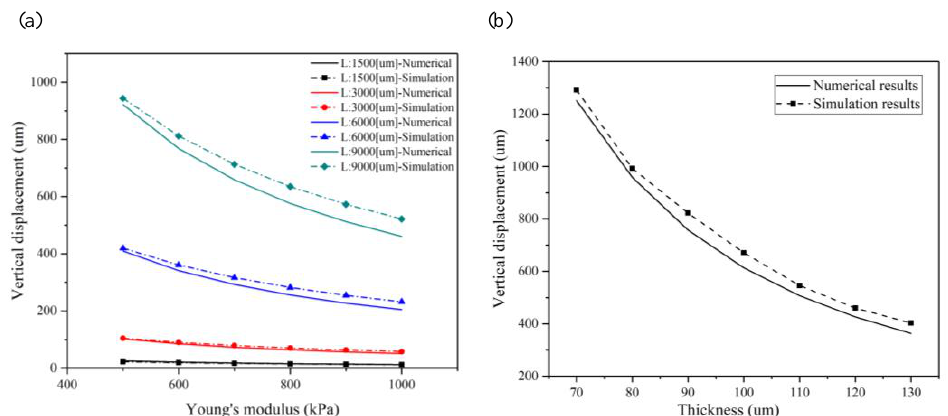
Figure 5. The numerical and simulation results of the maximum displacements at the free end of the perforated microcantilever with a different Young’s modulus and substrate thickness: ( a ) the effect of Young’s modulus on a maximum displacement of the perforated microcantilever with different sizes ( L * b * t f is 6000 μm * 2000 μm * 100 μm; d is 60 μm; q 1 is 300 μm; and q 2 is 100 μm) when the contractile force is 2 nN/μm 2 ; ( b ) the effect of substrate thickness on the maximum displacement when the microcantilever length is 9000 μm and the contractile force is 2 nN/μm 2 .